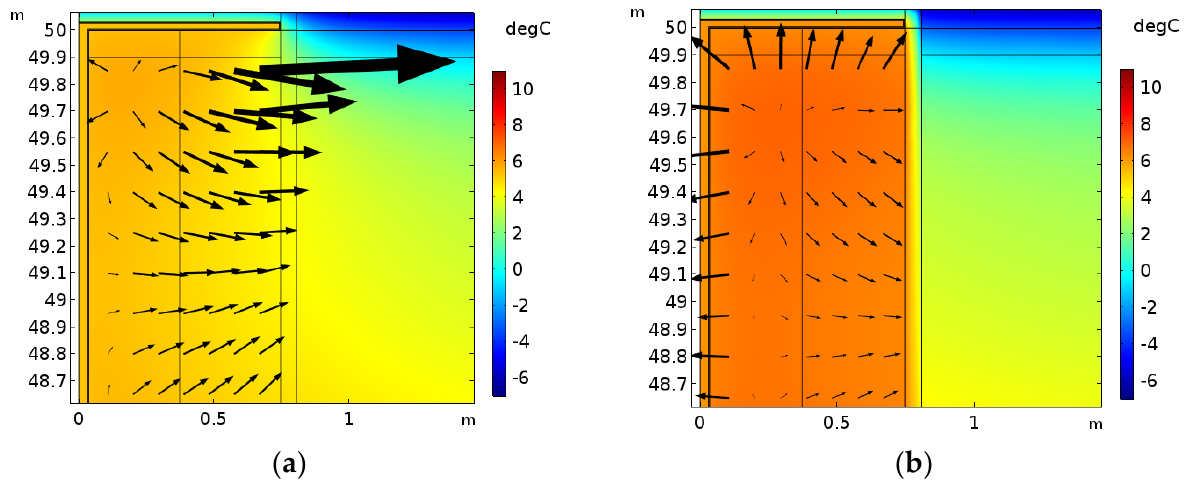
Figure 9. Temperature profile on the 2-D axisymmetric surface and conductive heat flux represented by arrows: (a) system without insulation and (b) system with insulation.